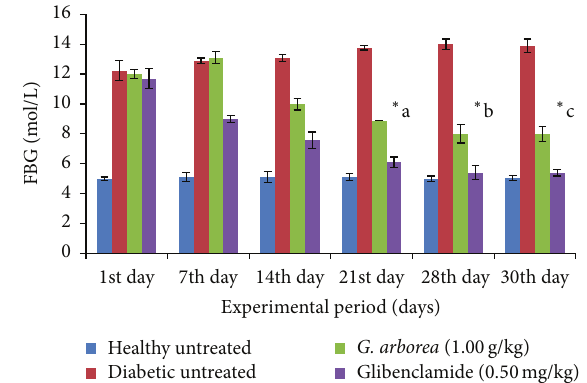
Figure 1: Effect of aqueous bark extract of Gmelina arborea (1.00 g/kg) fasting blood glucose concentration (FBG) in strepto- zotocin induced diabetic rats for 30 days. Data are expressed as mean ± SEM ( 𝑛 = 6 /group). From the 21st day onwards, the fasting blood glucose concentration of G. arborea (1.00g/kg) treated rats is significantly different from the fasting blood glucose concentration of diabetic untreated rats ( ∗ a, b, c).